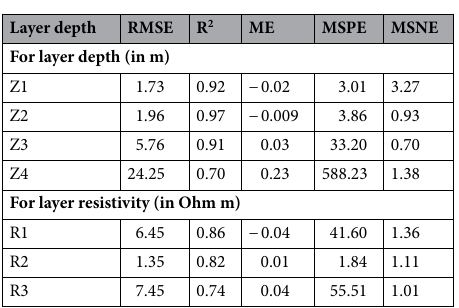
Table 2. Descriptive statistics for the depth values and the cross-validation for resistivities of the aquifer layers.